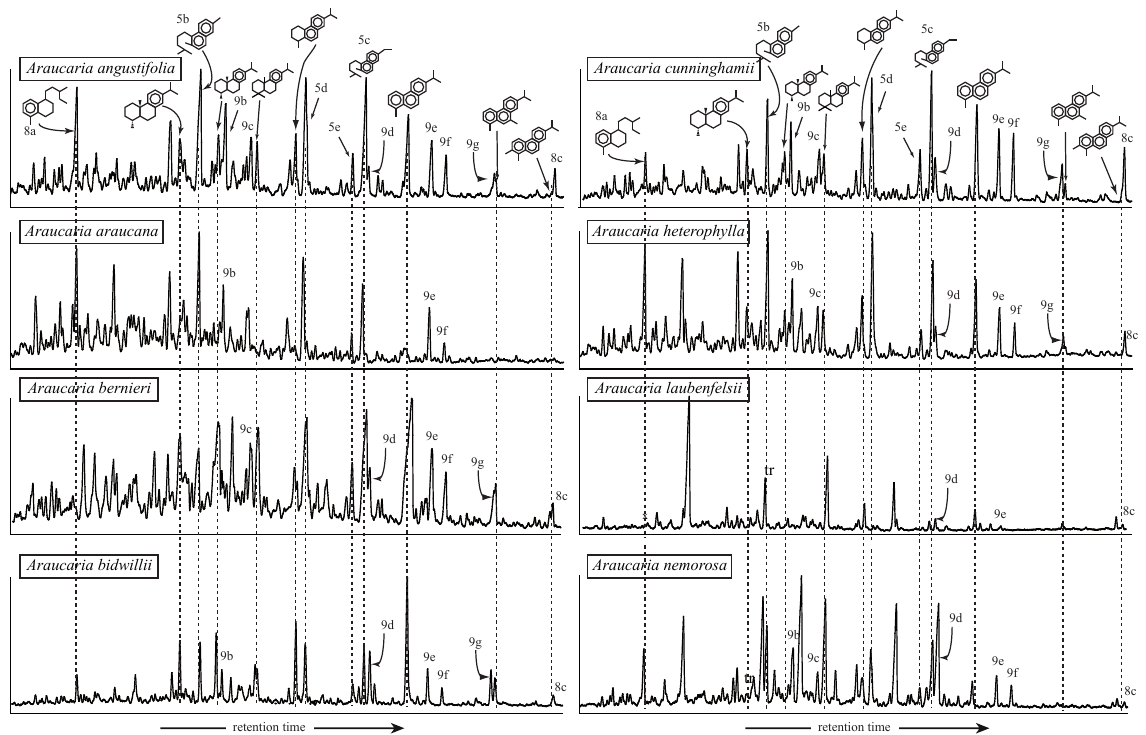
Fig. 7. Partial chromatograms (diterpenoids retention time window) of aromatic fractions of pyrolysates of Araucaria species. The mass spectra of 5b, 5c, 5d and 5e are given in Fig. 5. The mass spectra of 8a and 8c are given in Fig. 8. The mass spectra of 9b, 9c, 9d, 9e, 9f and 9g are given in Fig. 9. tr: in trace; x : absence of